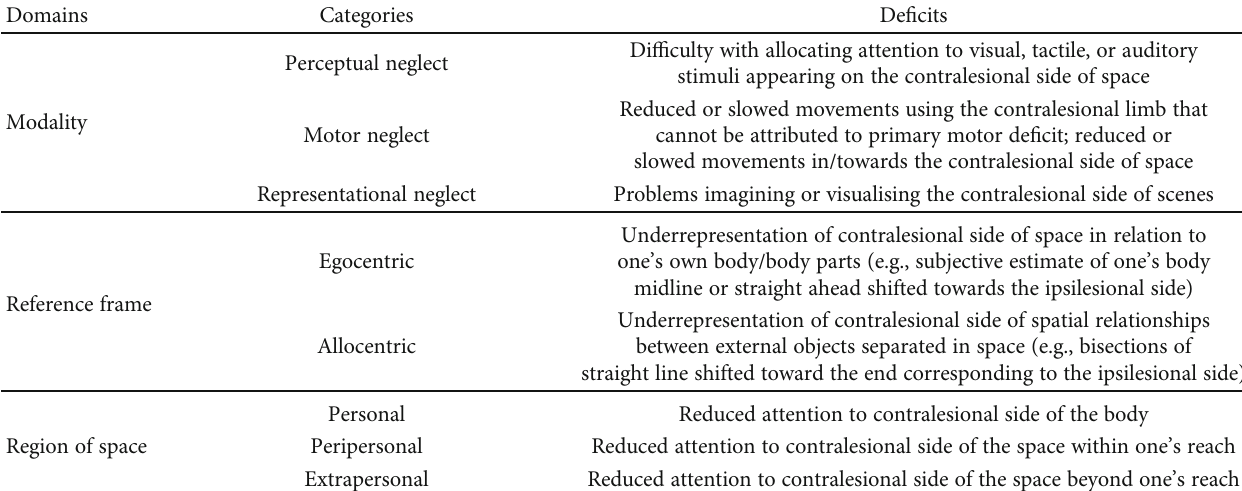
Table 3: Poststroke hemispatial neglect